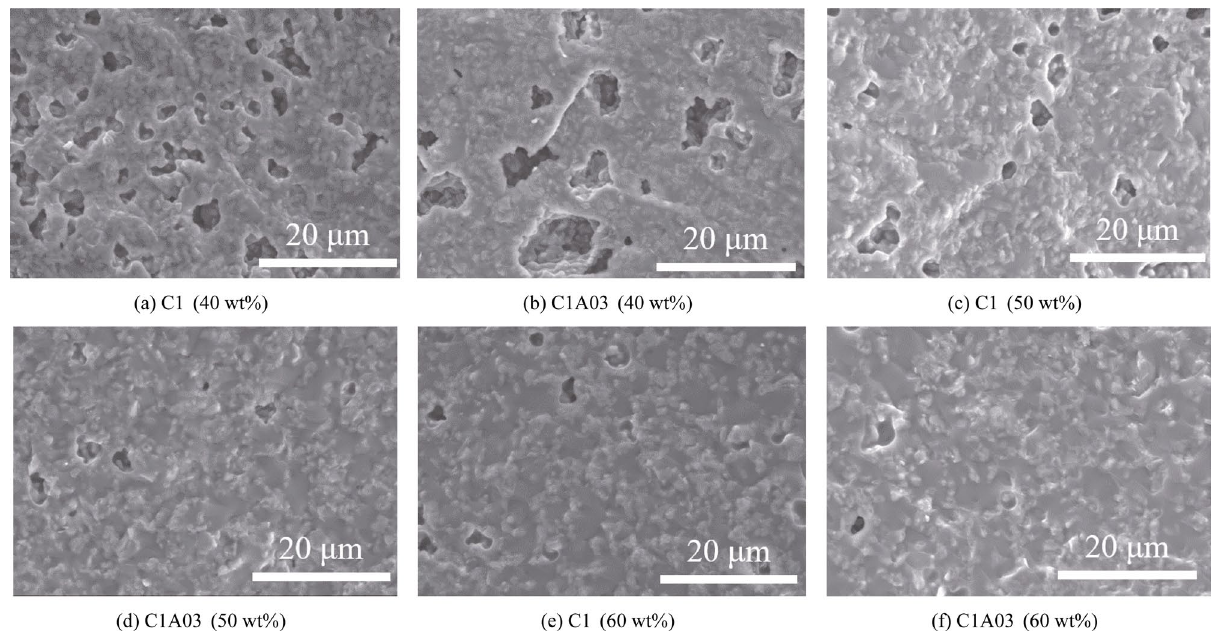
Fig. 5 Microstructures of Ca 0.7 Nd 0.2 TiO 3 added with various amounts of C1 and C1A03 glasses after sintering at 900 ℃ .